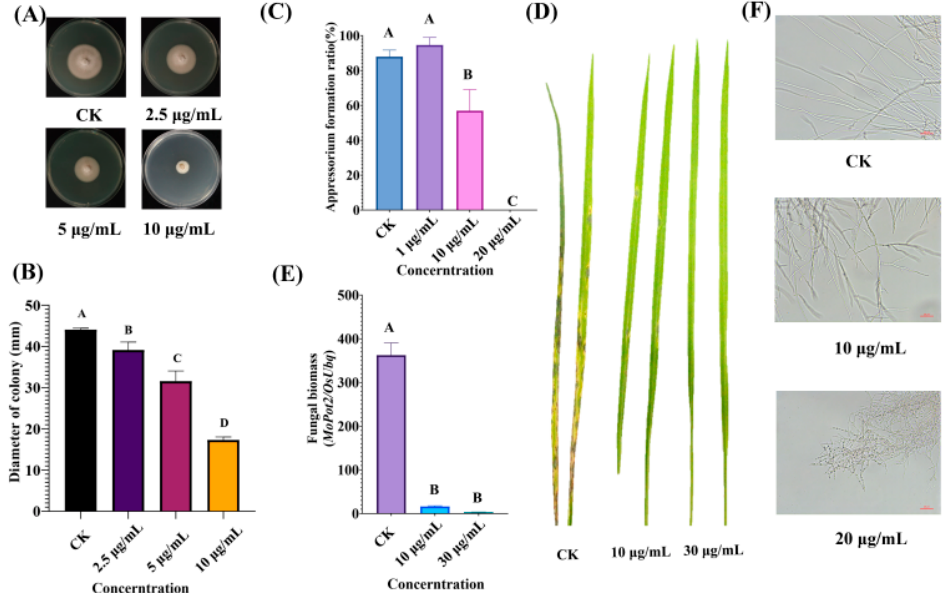
Figure 1. The inhibitory effects of 9-phenanthrol on blast growth and pathogenicity. ( A ) The effect of 9-phenanthrol on mycelial growth ( A , B ) and appressorial formation ( C ). Application of 9-phenanthrol decreases the pathogenicity and biomass of M. oryzae ( D , E ). The morphological changes of hypha with 9-phenanthrol treatment ( F ). Values are presented as the mean of results of triplicate experiments ± SD. Bars with different capital letters indicate significant differences between treatments at a p -value < 0.01 using a Duncan statistics